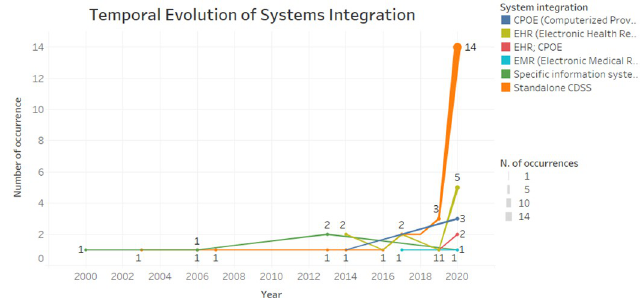
Fig 5. Temporal evolution of system integration.